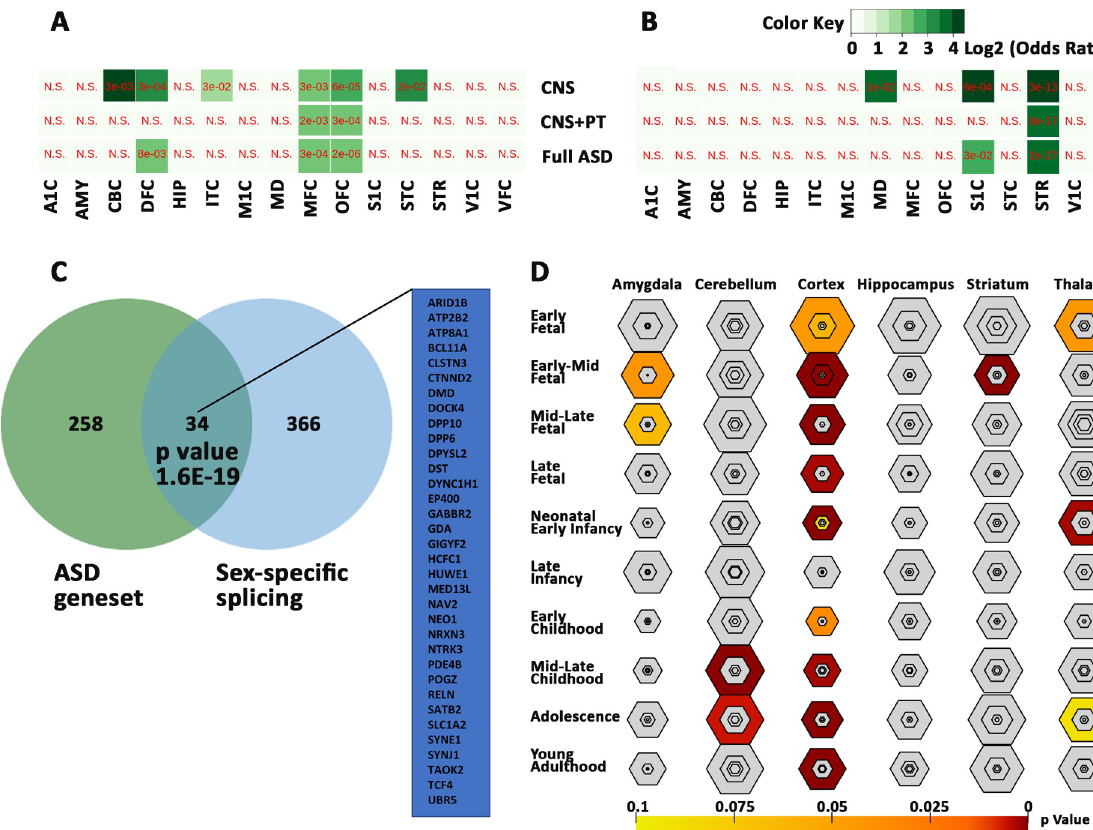
Fig 8. Sex-biased expression of the ASD genesets. Biased expression of the ASD genesets in female (A) and male (B) brain regions. Values are expressed as FDR in red and Log2 odds ratio in green with gradients. N.S for not significant. (C) Overlap of 34 ASD genes with sex-biased splicing genes. (D) Bullseye plot showing enrichment of ASD geneset in brain regions with most significant correlation in cerebral cortex throughout brain development. A1C -primary auditory cortex, AMY—amygdaloid complex, CBC—cerebellar cortex, DFC -dorsolateral prefrontal cortex, HIP—hippocampus, IPC—posterior inferior parietal cortex, ITC—inferolateral temporal cortex, M1C-primary motor cortex, MD—mediodorsal nucleus of thalamus, MFC—medial prefrontal cortex, OFC -orbital frontal cortex, S1C - primary somatosensory cortex, STC—posterior(caudal) superior temporal cortex, STR -striatum, VFC—ventrolateral prefrontal cortex, and V1C - primary visual cortex.